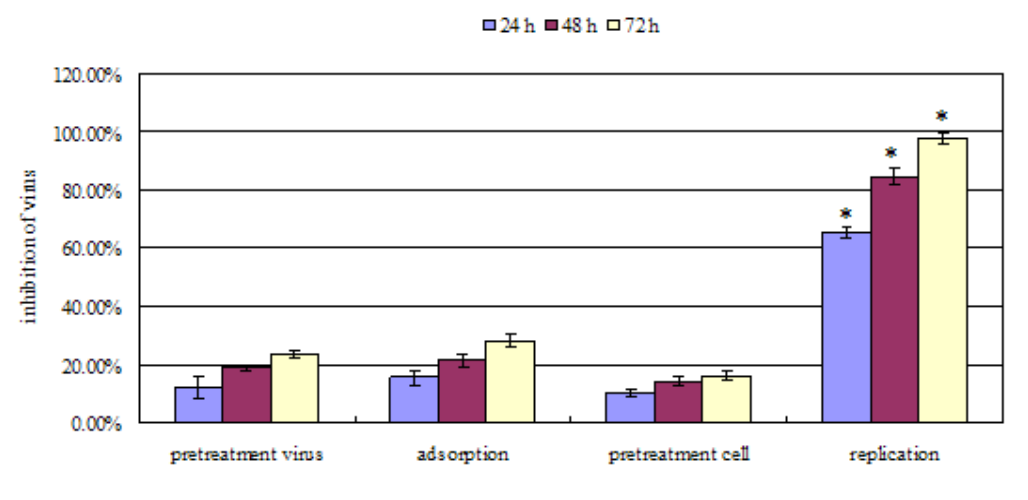
Figure 2. Antiviral effect of patchouli alcohol against influenza A (H2N2) virus by incubation at different periods of time during